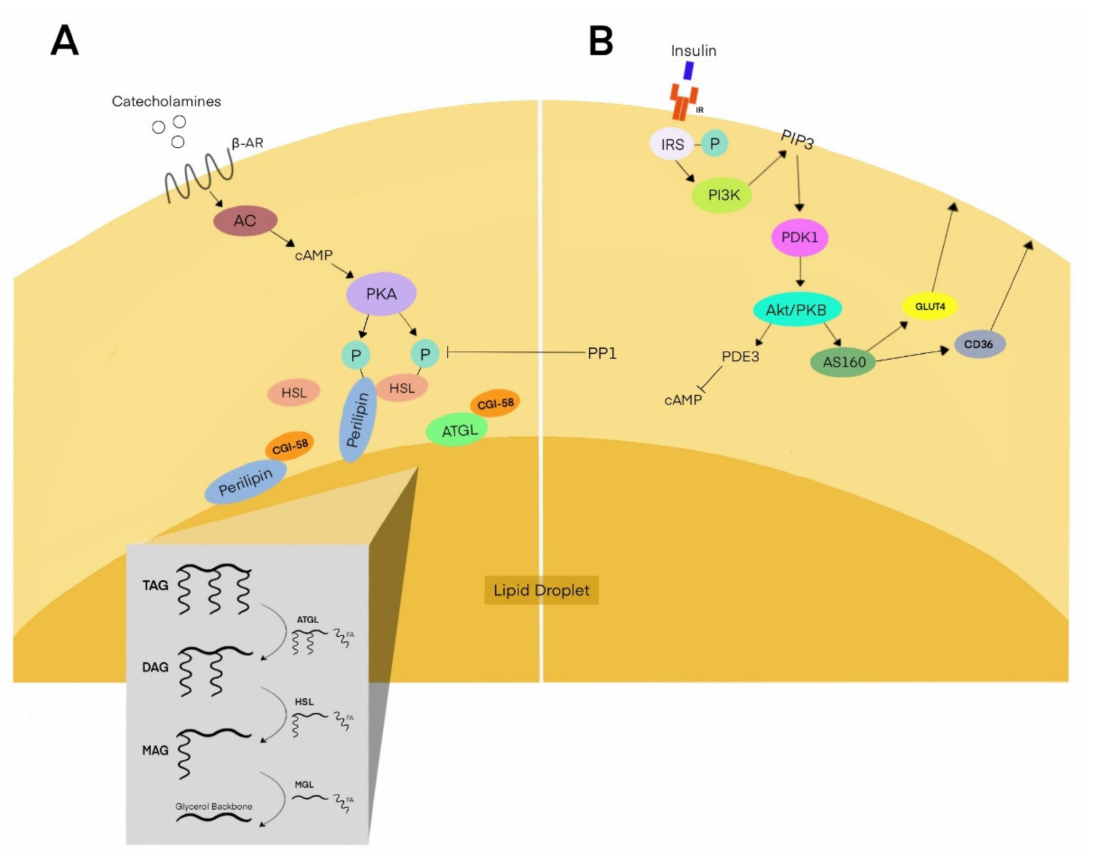
Figure 1. Lipid secretion and storage model. ( A ): Catecholamine stimulation of lipolysis results in cAMP accumulation, PKA activation, and phosphorylation of lipolytic enzymes. A Insert: Stepwise hydrolysis reactions mediated sequentially by ATGL, HSL, and MGL. ( B ): Insulin stimulates the PI3K/Akt pathway to decrease lipolysis via lowered cAMP and activation of protein phosphatase 1. Simultaneously, AS160 downstream of insulin promotes CD36 and GLUT4 translocation from the cytosol to the cell